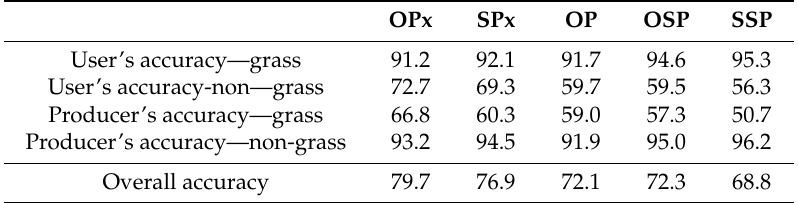
Land use classification accuracy for pixels only within the reference data. optimized-pixel (OPx); standard-pixel (SPx); optimized-parcel (OP); optimized-shrunken-parcel (OSP); standard-shrunken-parcel